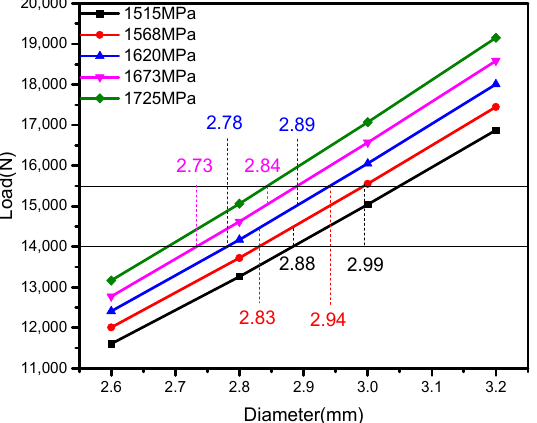
Figure 14. Tensile loads of bolts with different tensile strength–notch bottom diameter pairs.